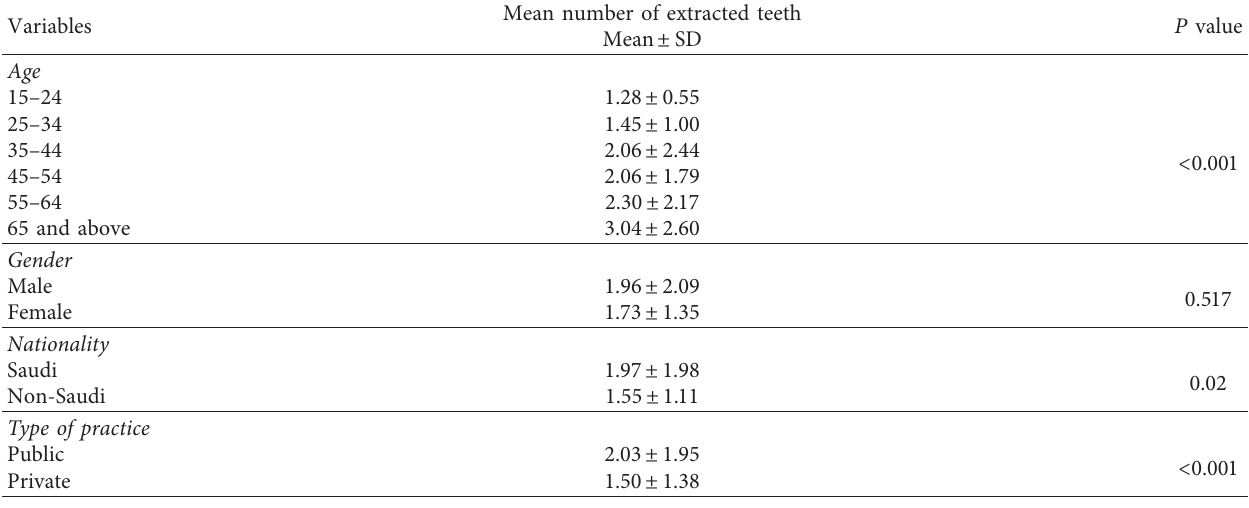
Table 2: Relationship between demographic factors and teeth extractions.